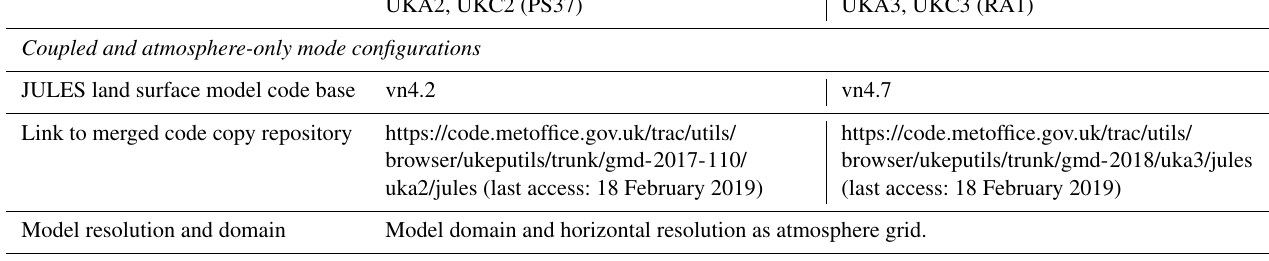
Table 6. Summary of UKA3 land surface component, and key similarities and differences to the UKA2 configuration described by Lewis et al. (2018). The direct links to merged code are provided to support collaboration with registered researchers. Further information on accessing JULES can be found at http://jules.jchmr.org (last access: 18 February 2019). UKA2, UKC2 (PS37) UKA3, UKC3